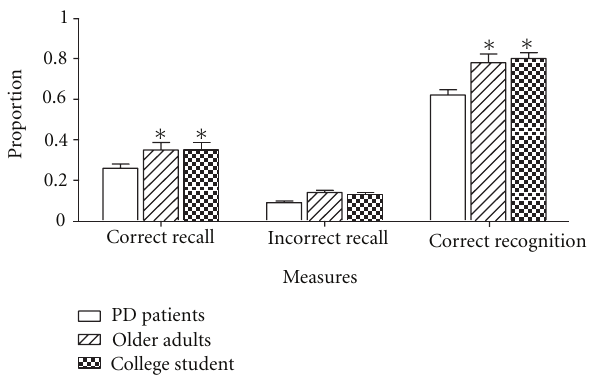
Figure 3: Do not know and TOT reports (in proportion to 30 general knowledge questions), TOT accuracy (gamma correlation), for college students (open bars), older adults (hatched bars), and Parkinson patients (stippled bars). ∗ P < . 05 compared to college